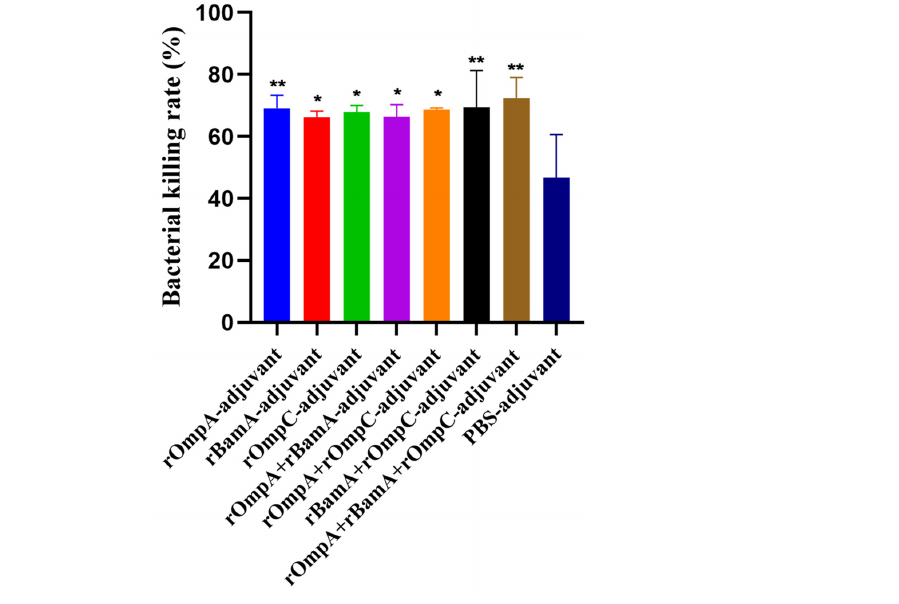
Figure 5. Opsonophagocytosis effect of the antisera in vitro. Colony counts of different groups were determined by plate count. The E. coli O78 (CVCC CAU0768) was incubated with antisera of the recombinant proteins immunization group or the PBS immunization group. Data are expressed as means ± SD, n = 3. “* and **” indicates a significant difference between the immunized group and the PBS-adjuvant group (* p ≤ 0.05, ** p ≤ 0.01).